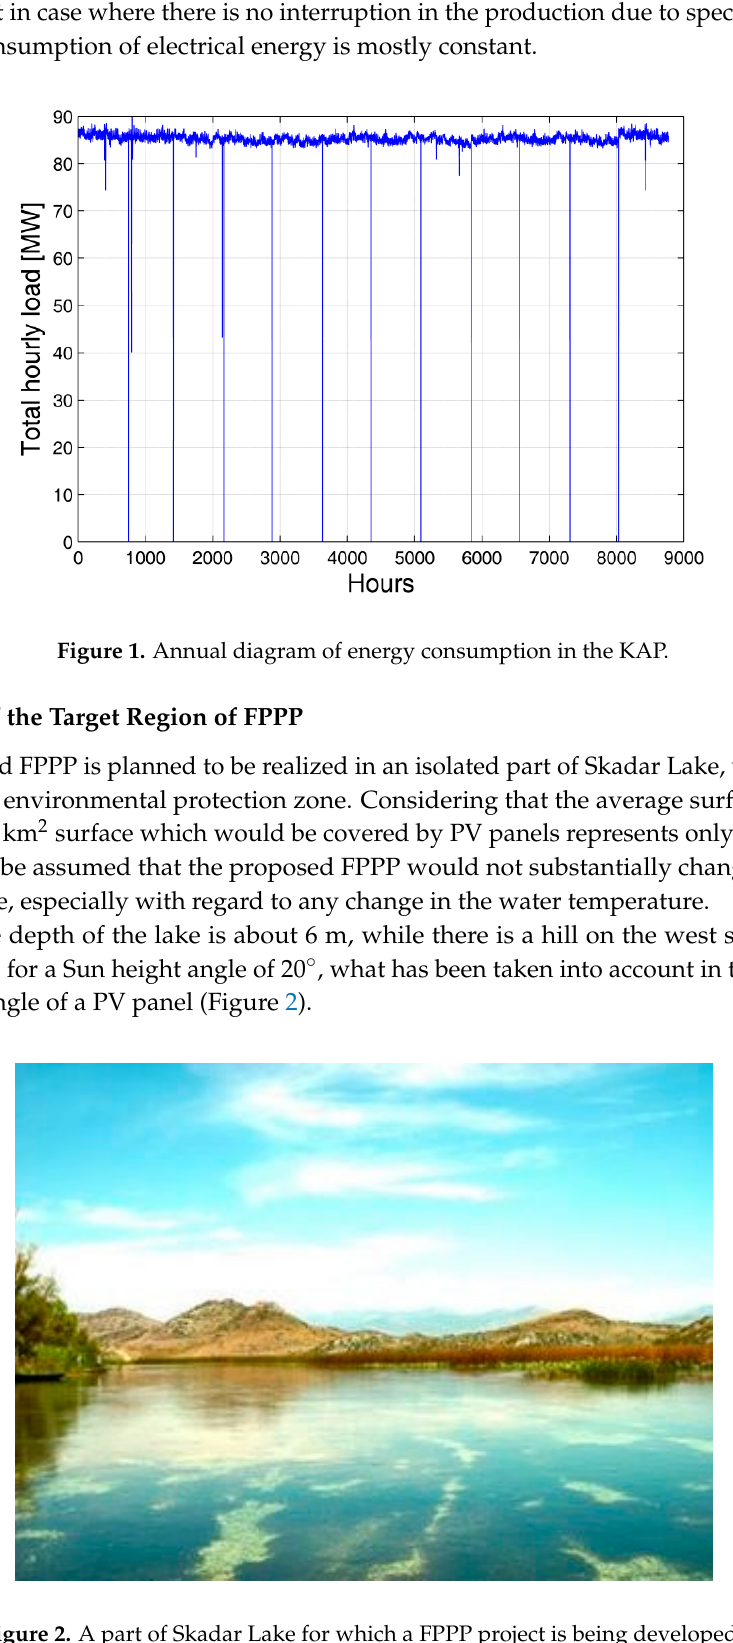
Figure 2. A part of Skadar Lake for which a FPPP project is being developed.